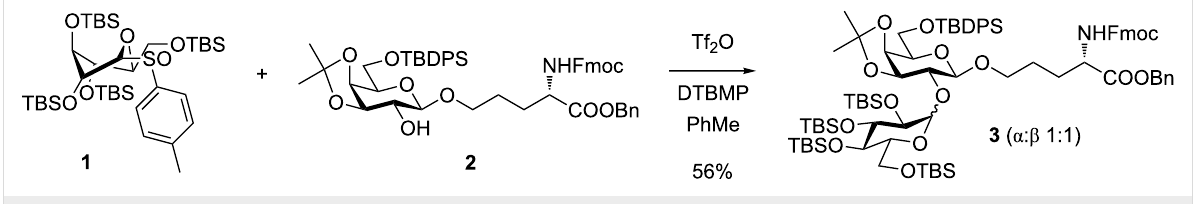
Scheme 1: Glycosylation with sulfoxide 1 .